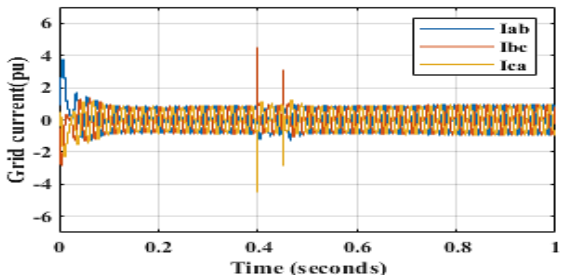
Inventions 2021 , 6 , x FOR PEER REVIEW Figure 13. Grid current of the DFIG system under scenario I. Figure 13. Grid current of the DFIG system under scenario I. Figure 13. Grid current of the DFIG system under scenario I.